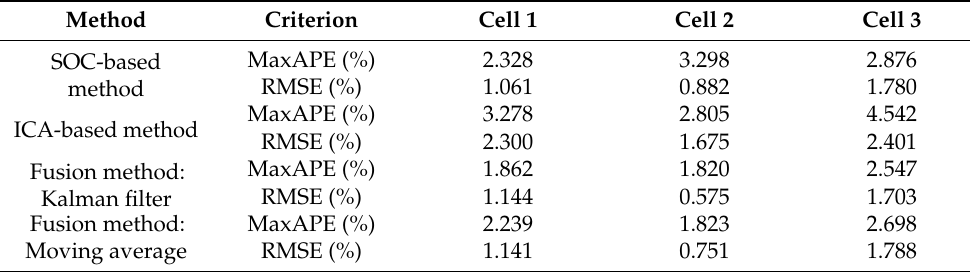
Table 2. The performance of different methods for different cells.